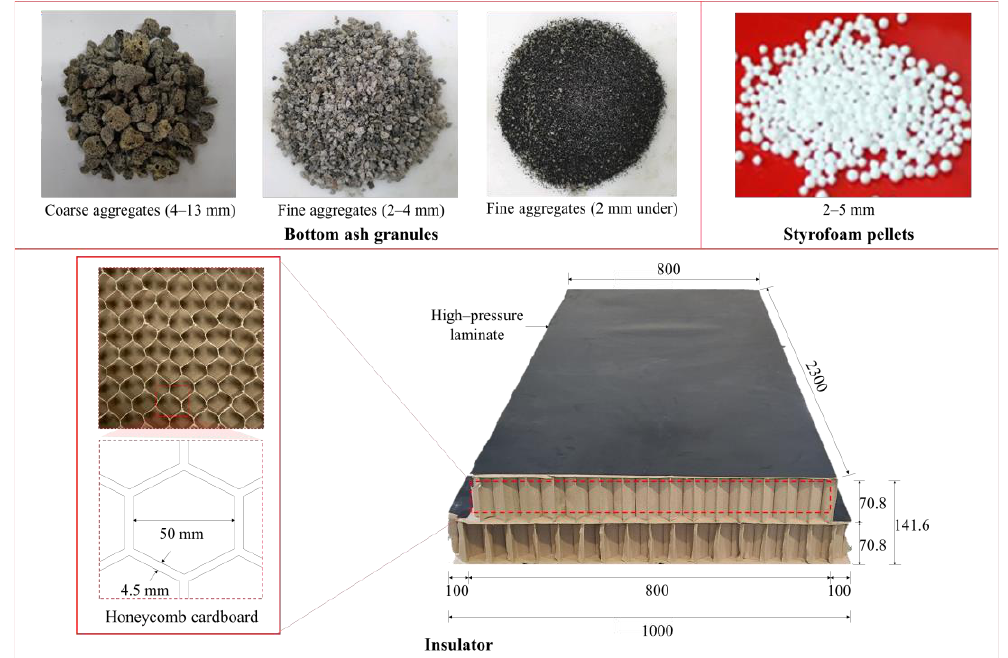
Figure 1. Materials used for concrete and thermal meta used for the insulator (units: mm).